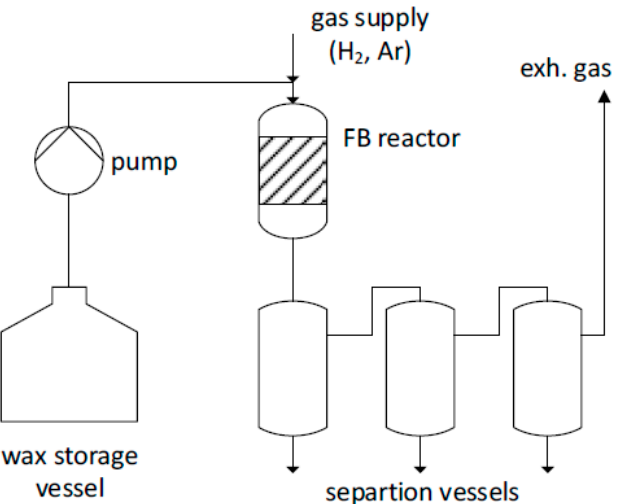
Figure 3. Three phase fixed-bed reactor at the Engler-Bunte-Institute (EBI) at KIT [27].